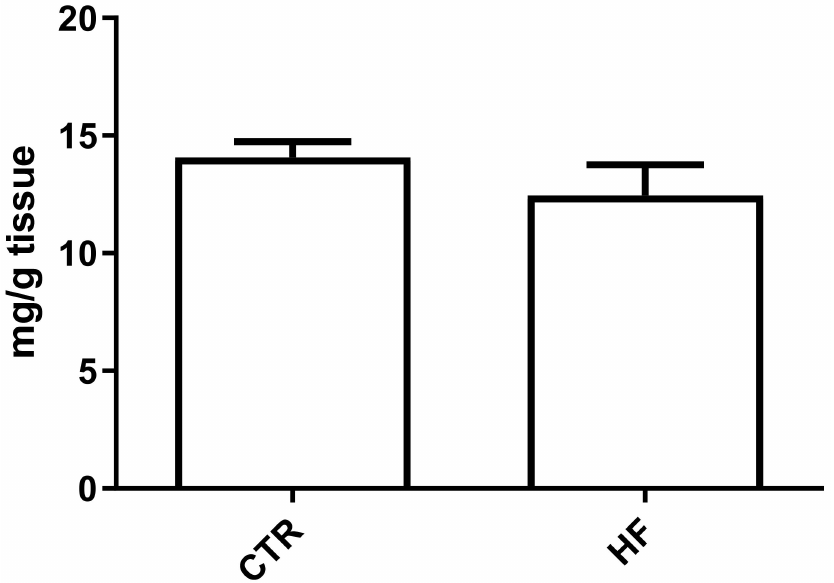
Figure 3. Lipid content in kidney. Quantification of neutral lipids was performed on total lipid extracts. Data are expressed as mean ± standard deviation. No difference was observed in lipid content between the high fat (HF) and normal chow (CTR)